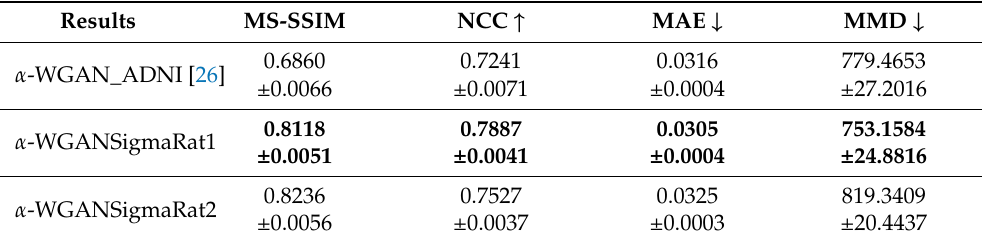
Table 2. Quantitative results. For each cell, the first value is the mean and the second is the standard deviation. The best results are in bold for each metric. An up arrow ↑ next to the metric name means that larger values are better, and a down arrow ↓ means the opposite.